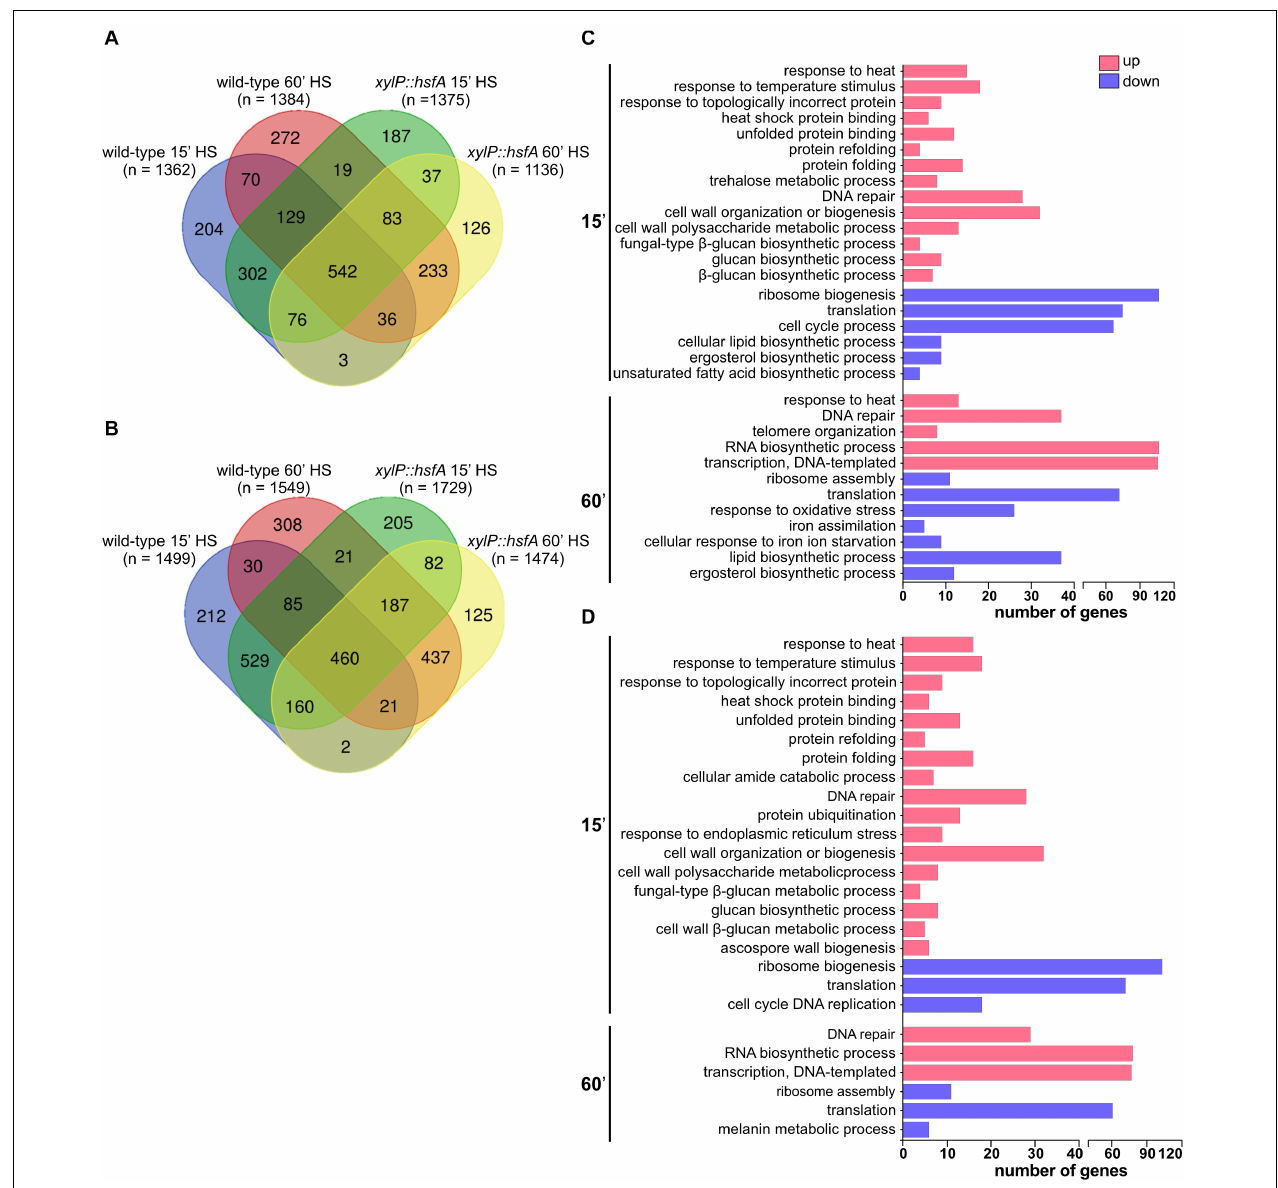
FIGURE 8 | Global transcriptional response of the wild-type and xylP::hsfA strains to HS. Venn diagram depicting the number of upregulated (log 2 FC ≥ 1.0) (A) and downregulated (log 2 FC ≤ –1.0) (B) genes in the wild type and xylP::hsfA strains post-15 min and 60 min of HS. (C) Selected Biological Process Gene Ontology terms enriched from significantly differently expressed genes (log 2 FC ≥ 1.0 or log 2 FC ≤ –1.0) in the wild-type strain during HS (15 min and 60 min time points), in comparison to control condition (30 ◦ C). (D) Selected Biological Process Gene Ontology terms enriched from significantly differently expressed genes (log 2 FC ≥ 1.0 or log 2 FC ≤ –1.0) in the xylP::hsfA strain during HS compared to control condition (30 ◦ C). For the full Biological Process Gene Ontology terms list, refer to Supplementary Table 5